Question: Condense the content of this figure into a single sentence.
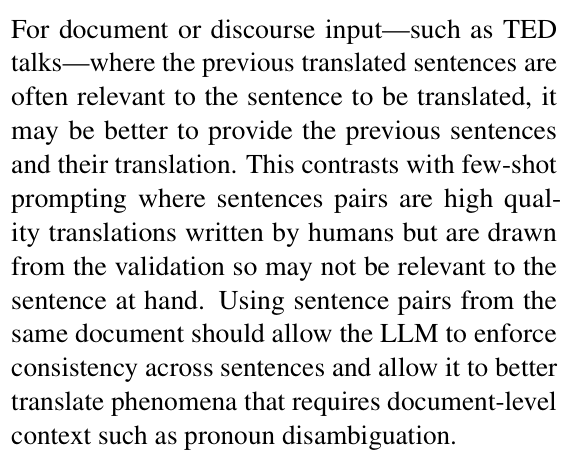
Answer: shows the COMET-22 score against the number of sentence pairs in the prompt on the TED-100 test set. Prompting the LLM with docu- ment context outperforms few-shot prompting and the ensemble with context (solid orange line) to outperform all variants of ensembling and LLMs with context or few-shots, as well as the MT model. Conditioning on the model’s own previous outputs from the same document context outperforms few- shot prompting with the human references of less related sentences. Prior work found that document level-specific evaluation is required to evaluate document level phenomena (Läubli et al., 2018; Toral et al., 2018; Vernikos et al., 2022). To this end, we use CTXPro (Wicks and Post, 2023), a specialized test suite